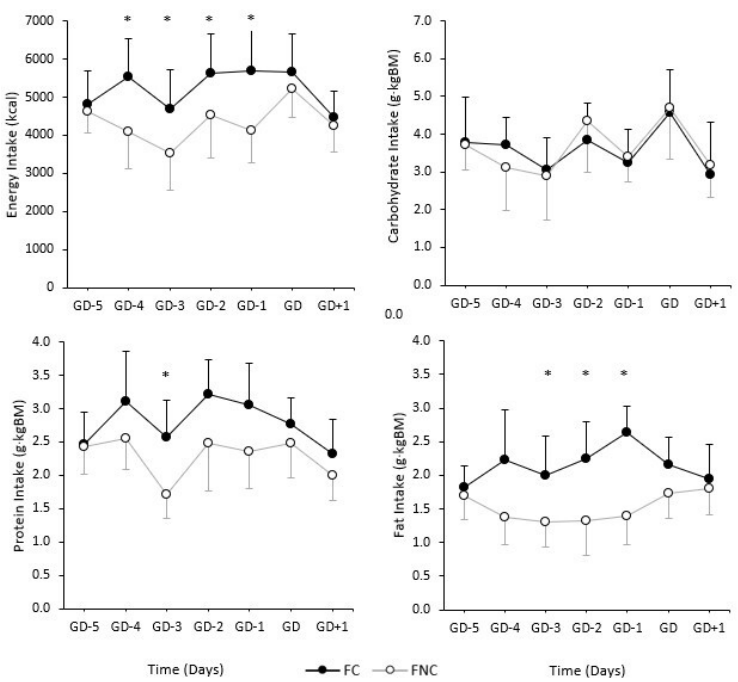
Figure 1. Daily absolute energy intake and relative macronutrient intake during competition weeks (GD-5, GD-4, GD-3, GD-2, GD-1, GD, GD + 1) among forwards within a catered (FC) and non-catered (FNC) environment. Error bars represent standard deviation. * Indicates a significant difference between FC and FNC.